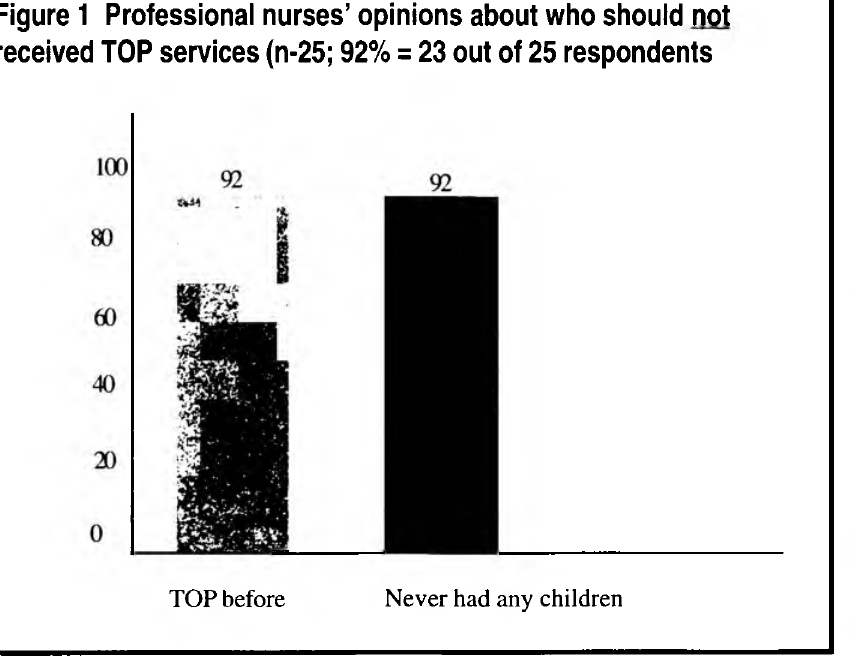
Figure 1 Professional nurses’ opinions about who should